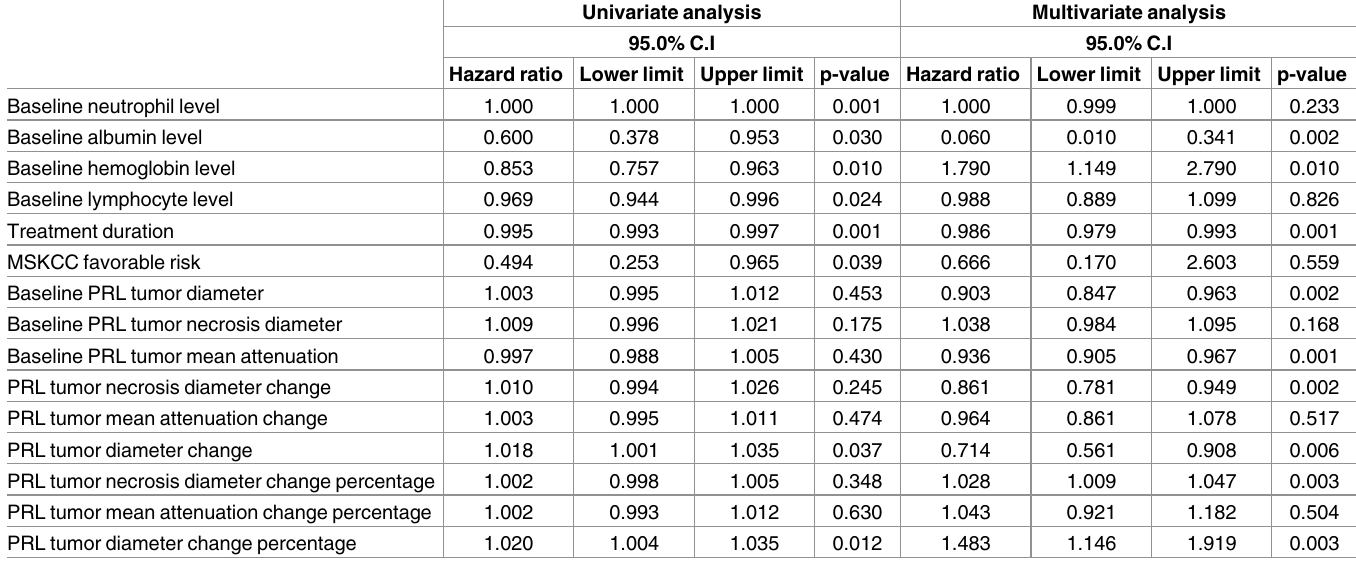
Table 2. Cox regression analysis of predictive factors of overall survival.